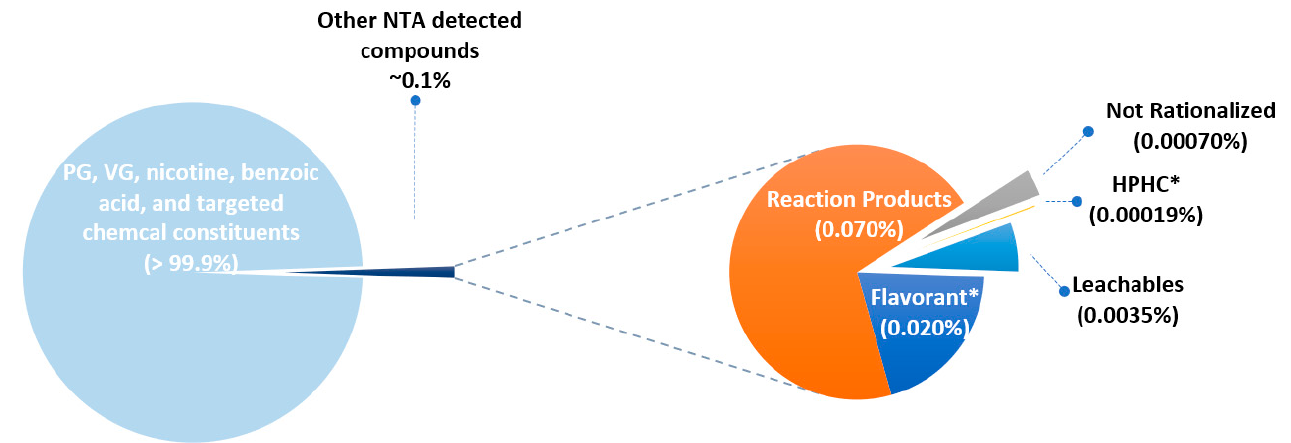
Figure 4. Percent total mass detected by GC and LC NTA methods under the intense and non-intense puffing regimen grouped by type for aerosol of Me5—the higher value from either intense or non-intense puffing results was used. See Tables 7 and 8 for more information. * Not detected by Chen et al. [58].